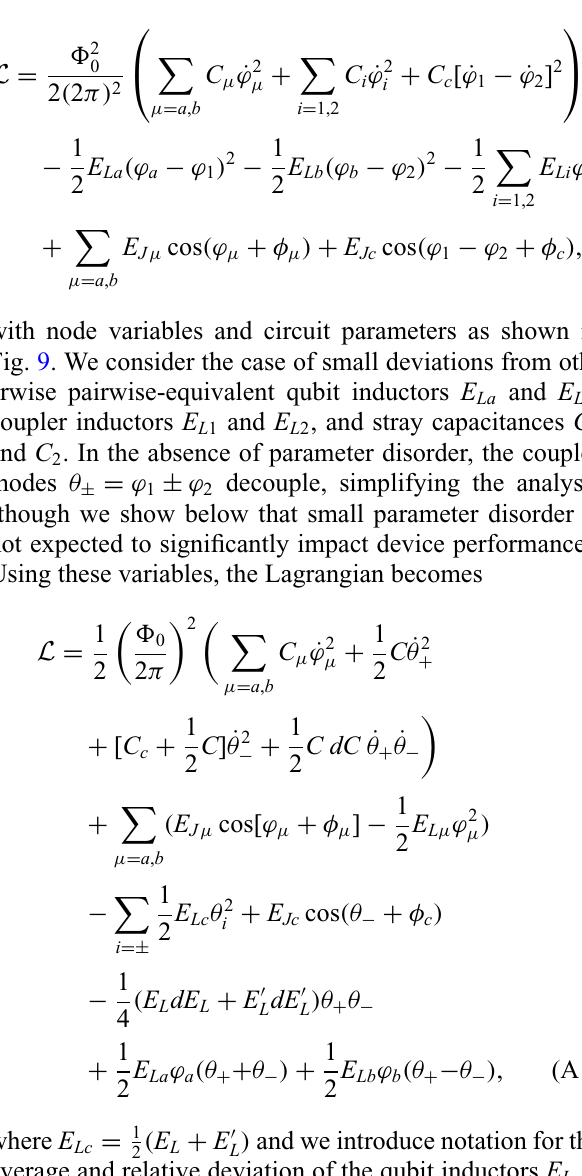
FIG. 9. A schematic of the full circuit, accounting for parame- ter